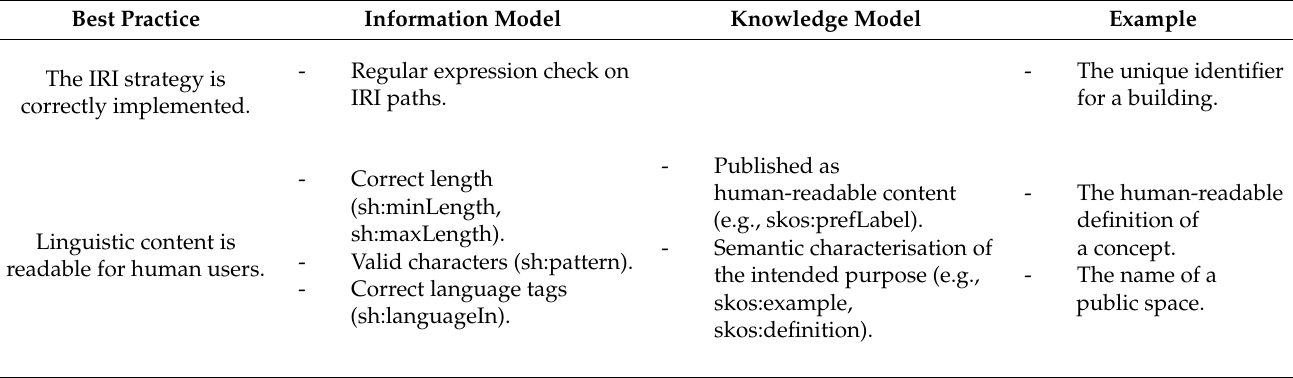
Table 1. Best practices used for validation of the Knowledge and Information Model.